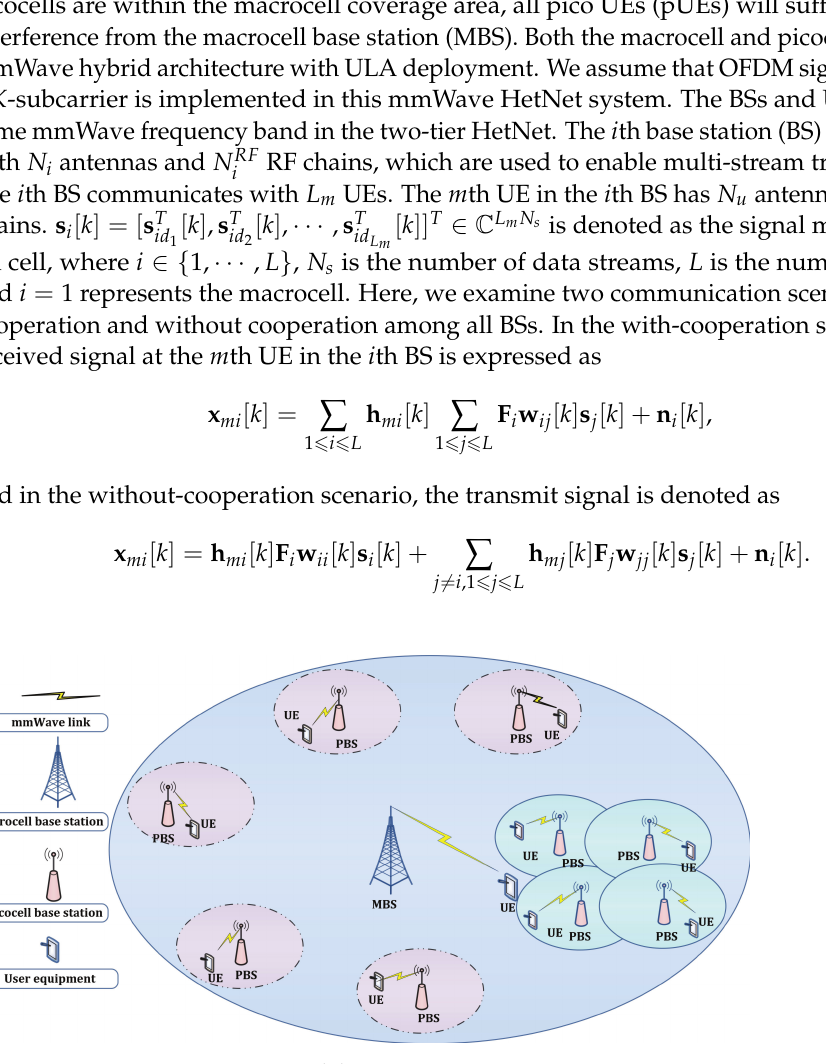
Figure 1. An mmWave HetNet